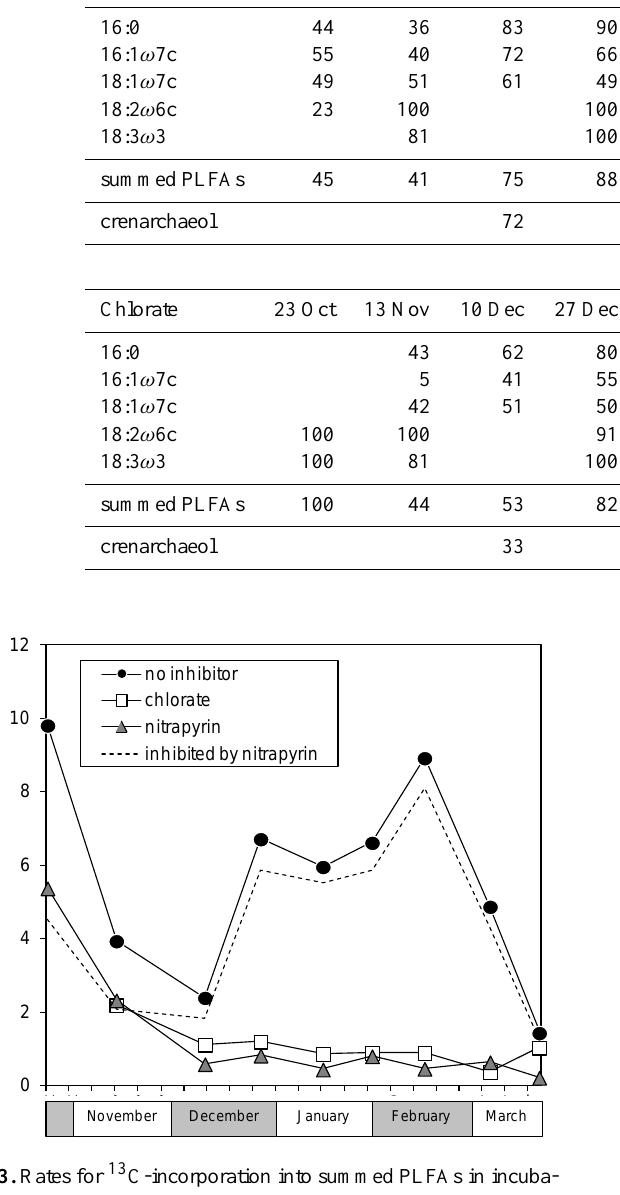
Fig. 4. Relative contributions (%) of individual PLFAs to 13 C-fixation in total PLFAs inhibited by nitrapyrin. Values are aver- ages for the whole sampling period, error bars indicate correspond- ing standard